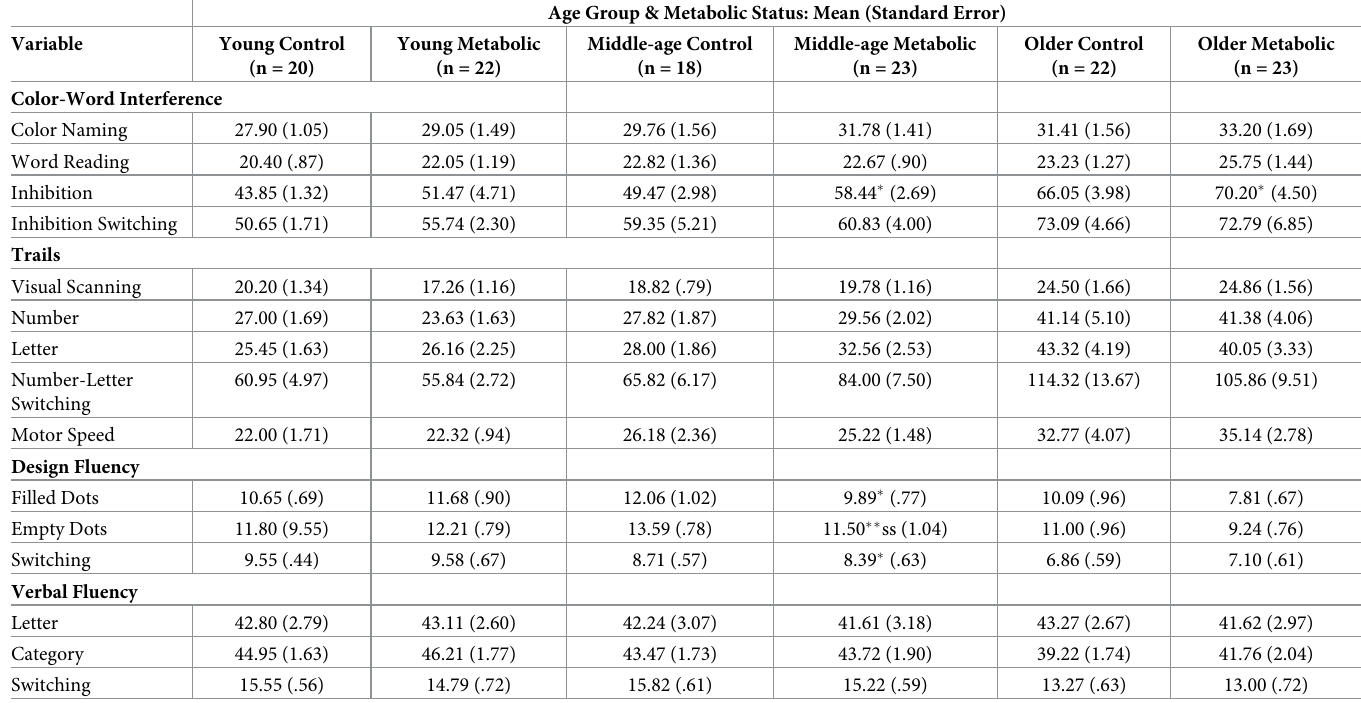
Table 8. Relationship between age, metabolic status, and cognitive functioning. Age Group & Metabolic Status: Mean (Standard